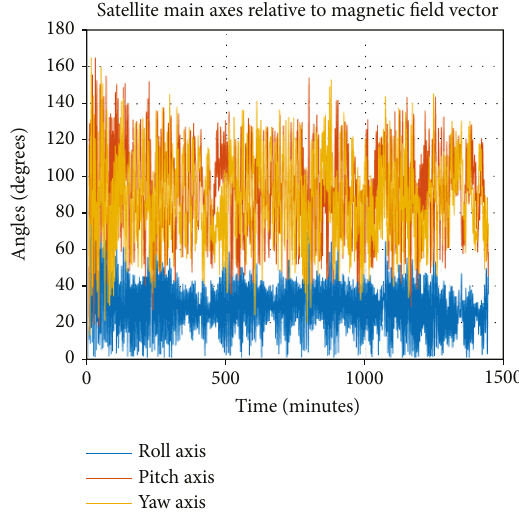
Figure 10: Simulated 3U CubeSat at ISS orbit, including aerodynamic torques. This fi gure shows the angles of the spacecraft ’ s primary axes and the magnetic fi eld vector. The spacecraft barely settles and tracks the magnetic fi eld within only 60 degrees. Inclusion of aerodynamics more realistically shows an outcome worse than expected. A redesign of the magnetic control system, e.g., selecting stronger magnets, could better overcome aerodynamic